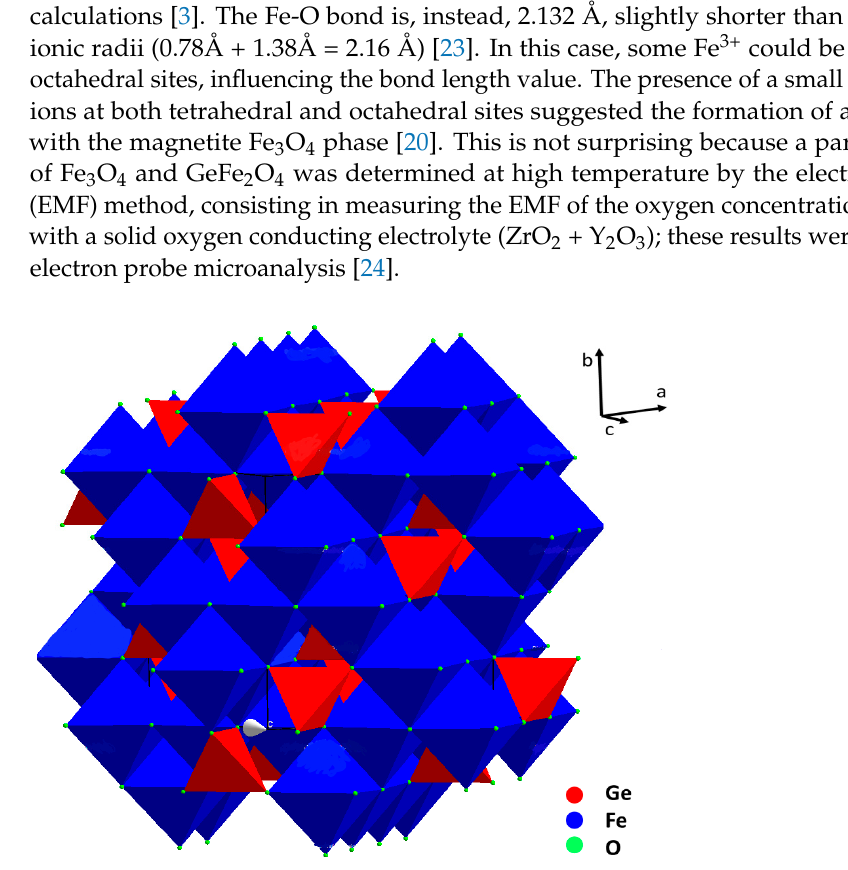
Figure 2. Representation of the brunogeierite crystal structure: FeO 6 octahedra (blue) and GeO 4 tetrahedra (red).